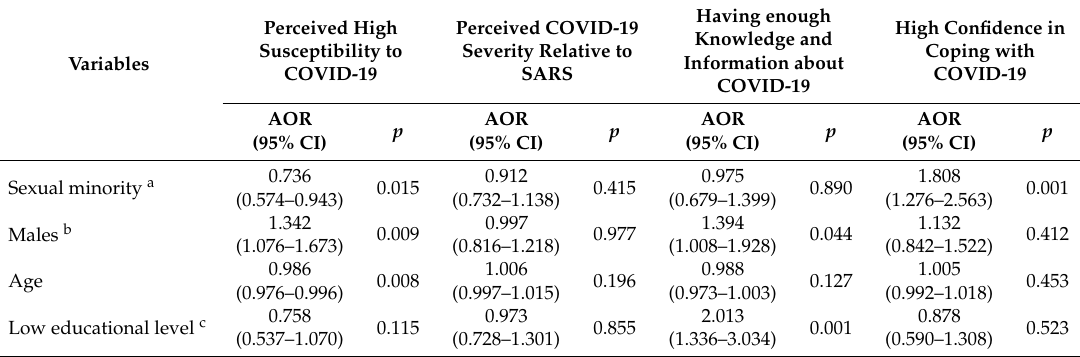
Table 2. Factors related to cognitive constructs of COVID-19 management.